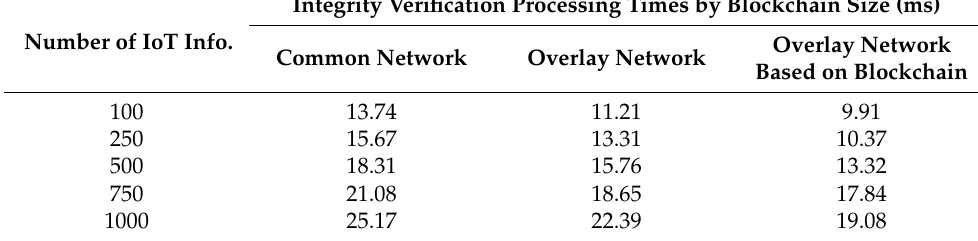
Table 6. Comparison of integrity verification processing times by blockchain size.